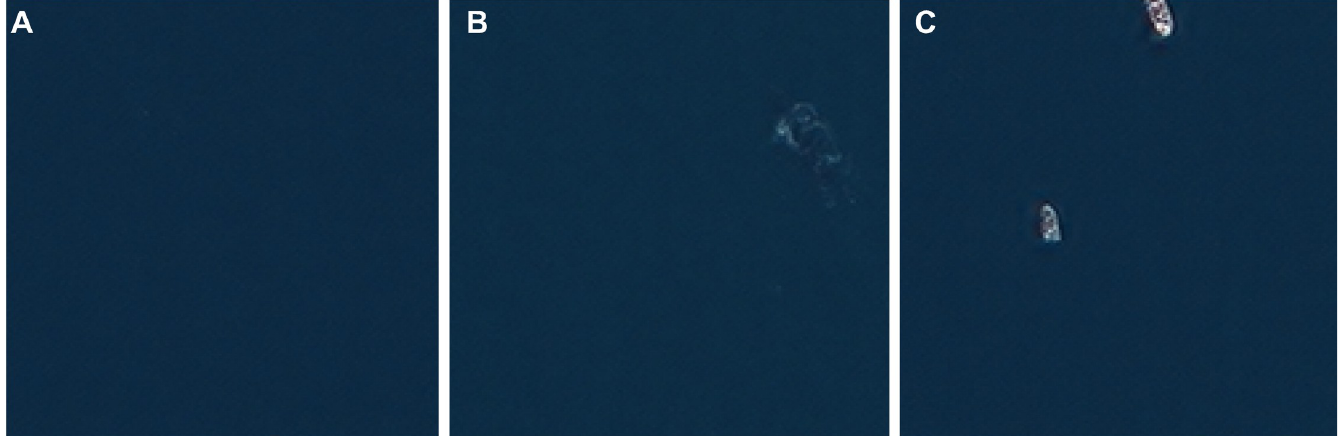
Fig 5. Example images. Open water (A), Southern right whale (B), whale-watching boat (C). Satellite imagery published under a CC BY license, with permission from the DigitalGlobe Foundation, original copyright 2014.